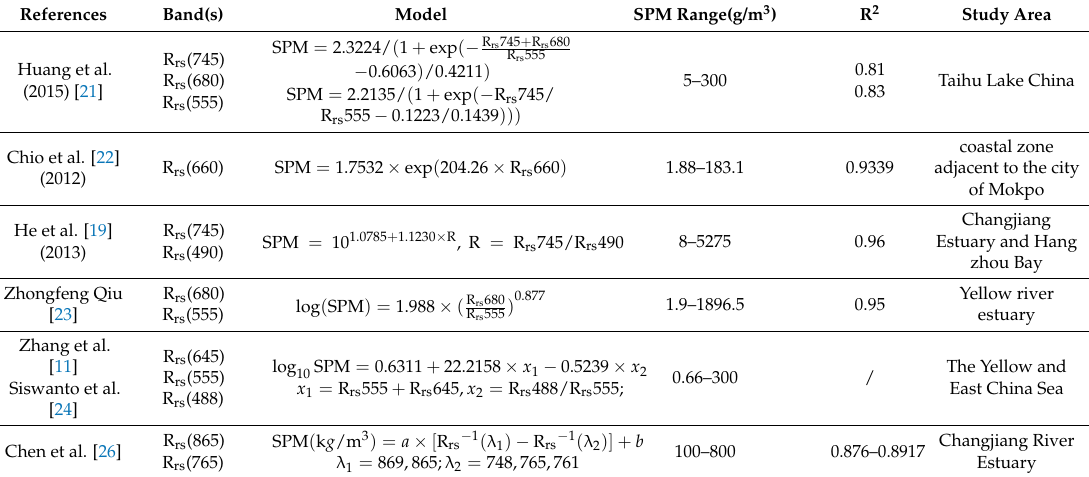
Table 1. SPM retrieval models that can applied in GOCI with alternative bands. Equations are listed as they were published in the reference papers, where R rs ( λ ) is the remote sensing reflectance at the wavelength of λ nm. R 2 is the determinate coefficient of calibrated